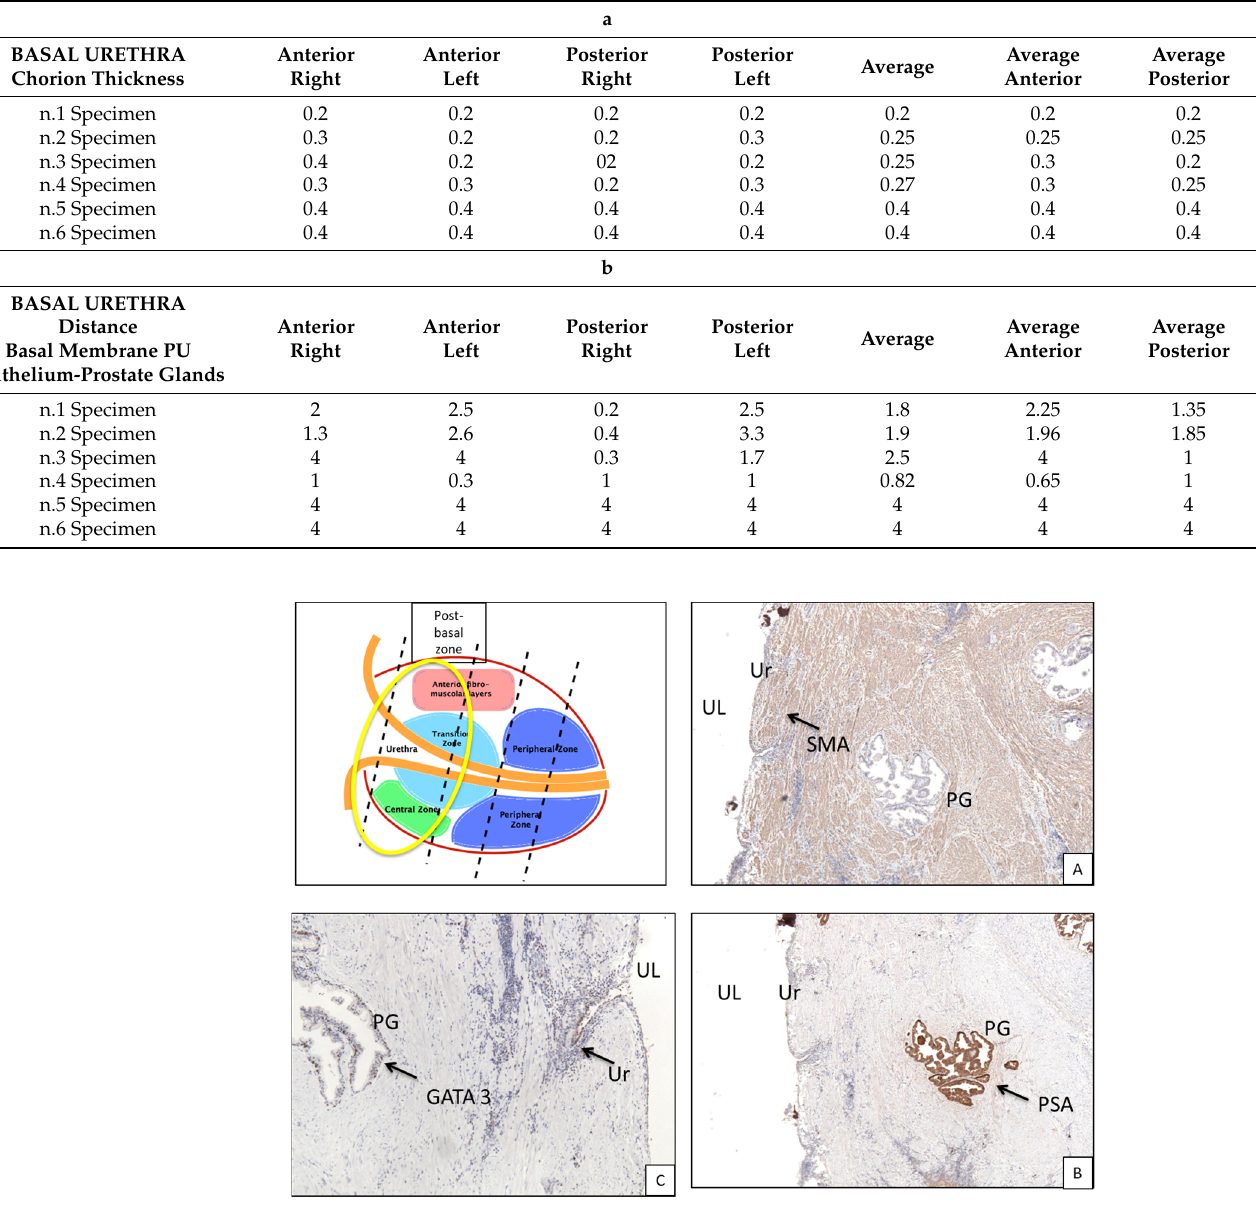
Figure 3. Basal portion of prostate gland from a cystoprostatectomy specimen. ( A ) Immunohistochemical staining for smooth muscle actin evidences the fibromuscular tissue around the prostatic urethra (arrow, 4× magnification). ( B ) Immunohistochemical staining for PSA reveals the presence of a prostatic-type gland right below the urethra epithelium (arrow, 4 × magnification). ( C ) Immunohistochemical staining for GATA3 evidences the presence of mixed epithelium of prostatic and urothelial type (arrows, 4× magnification). UL, urethral lumen; Ur, urothelium; PG, prostatic glands; Ch, chorion; SM, smooth muscle; SMA, smooth muscle actin. In the mid-glandular section, the average overall thickness of the chorion is 0.25 mm (Table 3a) with a mean difference of 0.04 mm between the anterior (0.27 mm) and posterior portion (0.23 mm). The prostate glands from the chorion are 1.49 mm apart (1.69 vs 1.29 mm for the anterior and posterior portion, respectively) (Table 3b). Concerning the PPUM, it is well represented, but decreases at the interface with the chorion, forming thin muscular fibers (Figure 4A). Table 3. a. Chorion thickness at the level of the middle PU. b. Distance between basal membrane of the PU epithelium and prostate glands at the level of the middle PU. a MIDDLE URETHRA Chorion Thickness